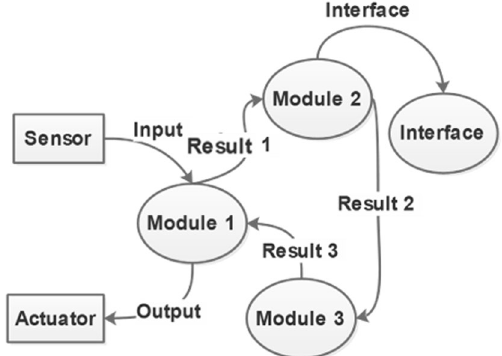
Fig. 2 The sequential applica- tion